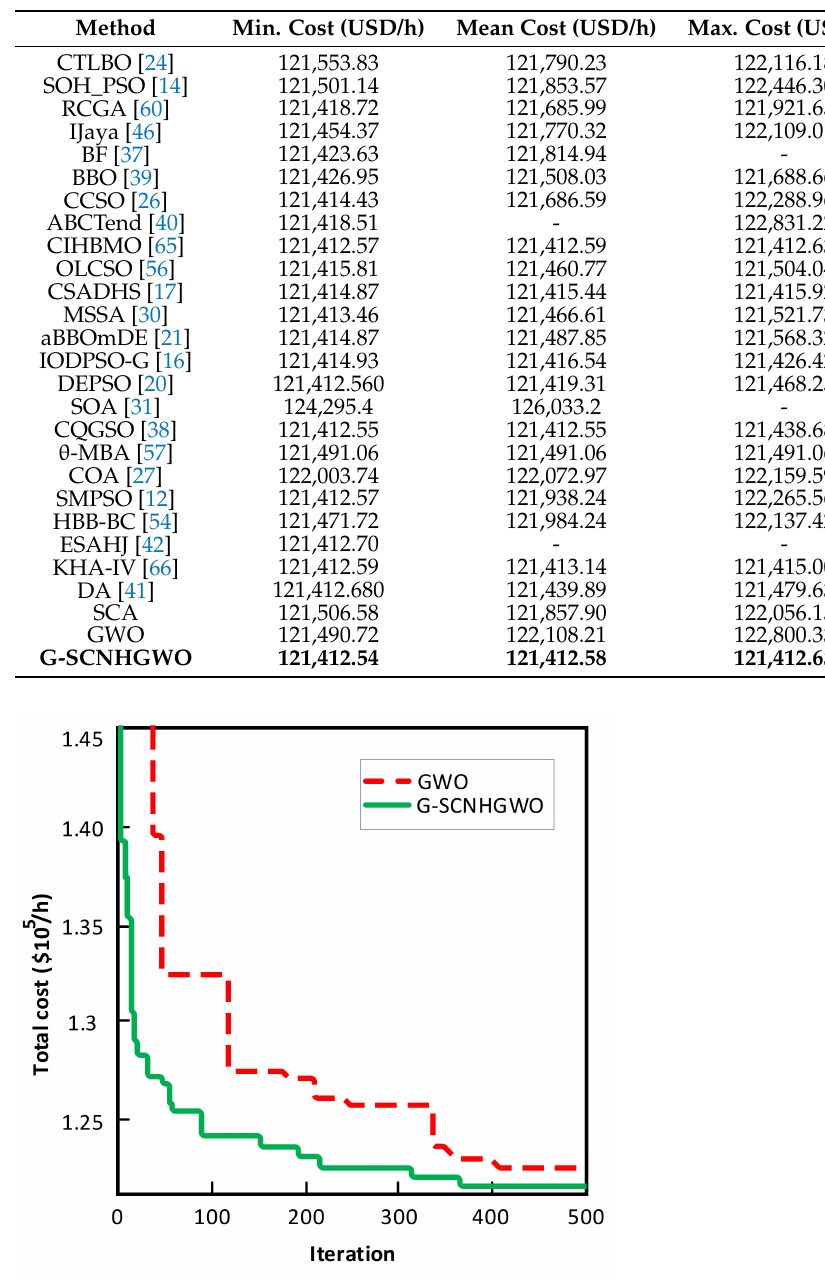
Figure 3. Convergence behavior of GWO and G-SCNHGWO algorithms in Case